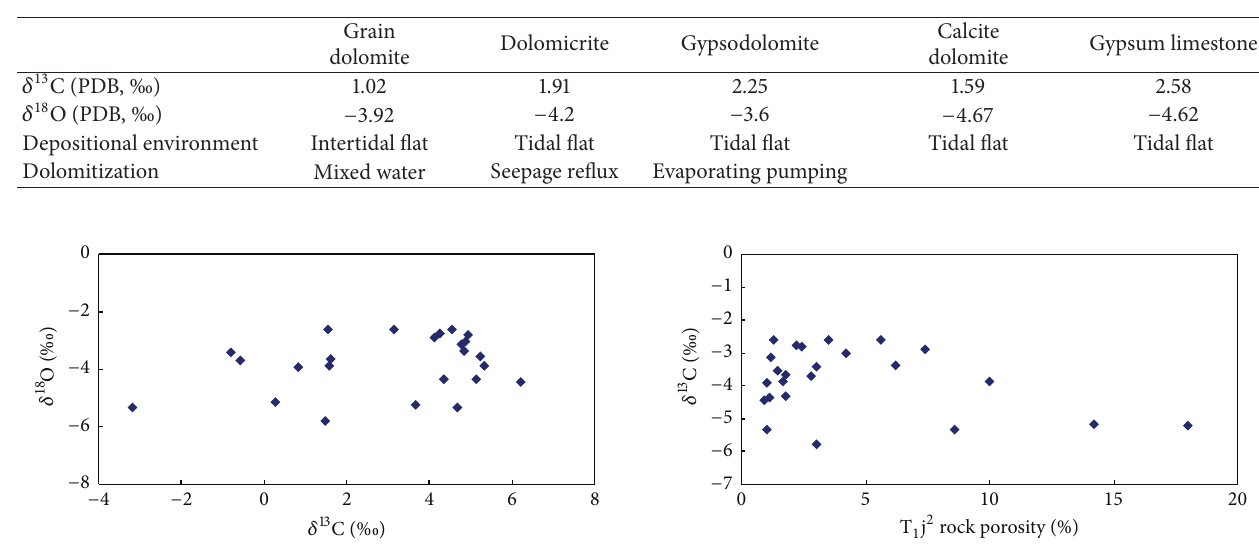
Table 2: Relationship between carbon and oxygen isotopic and sedimentary environment.